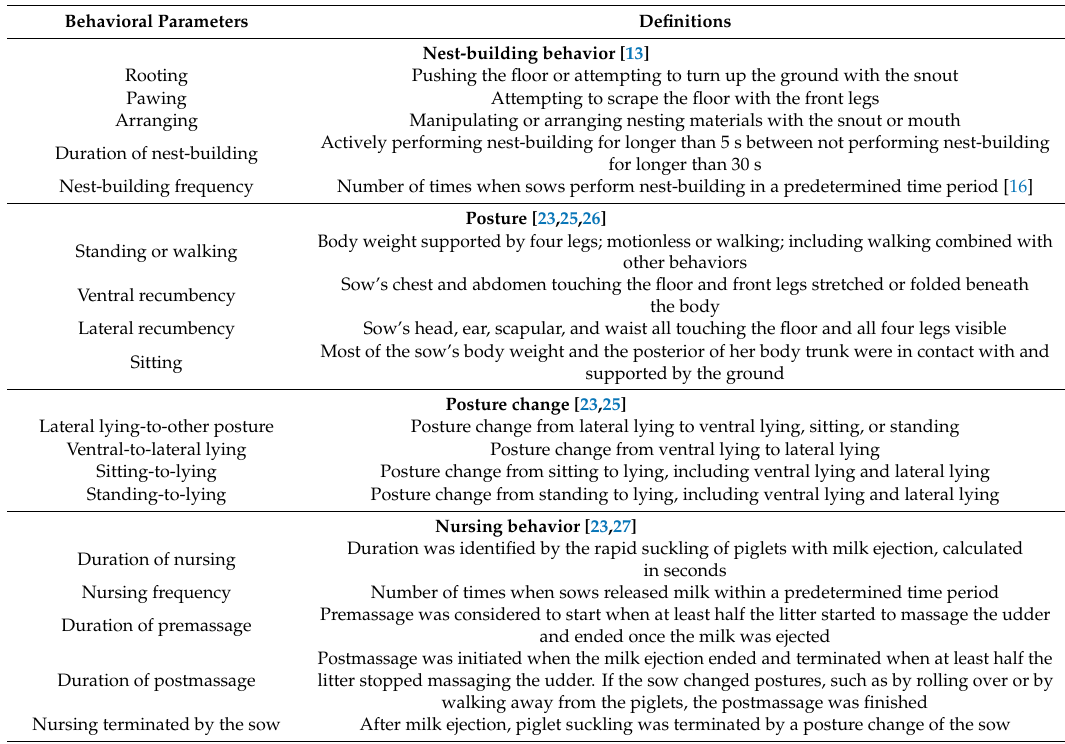
Table 1. Behavioral parameters and their